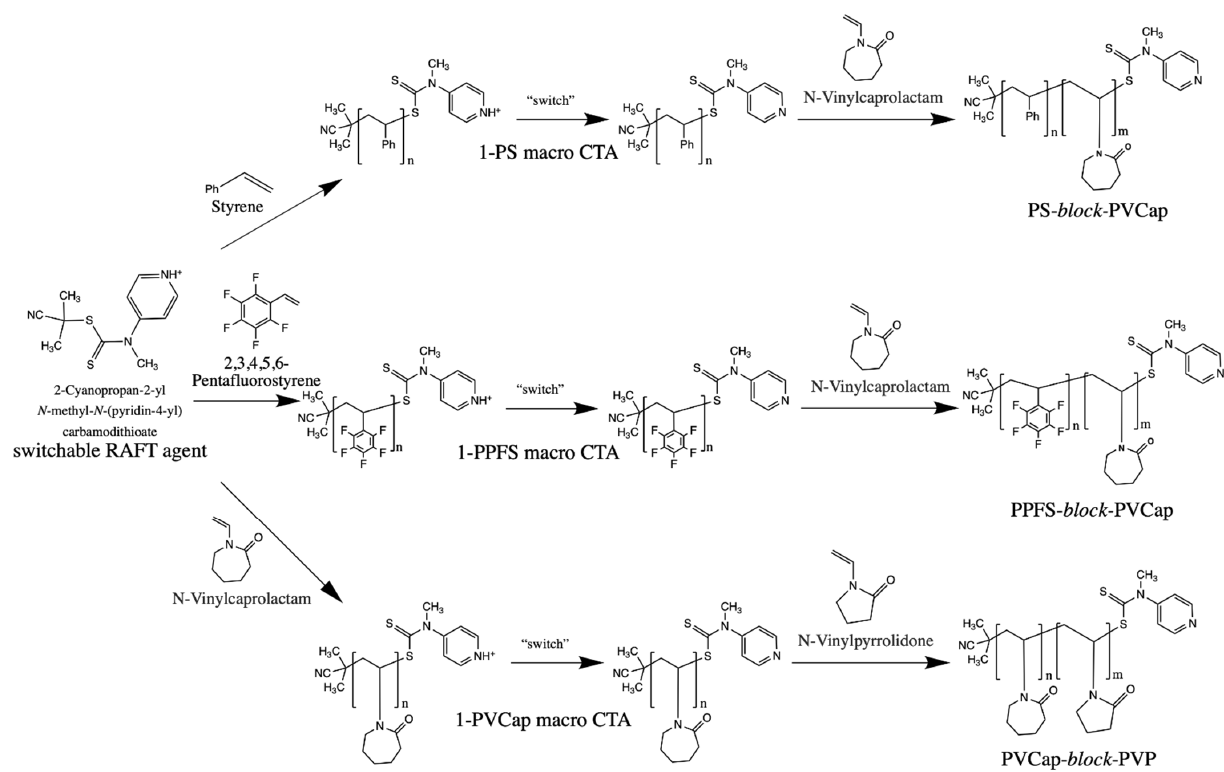
Figure 2. Reaction scheme for synthesis of (less activated monomer (LAM))-block-(more activated monomer (MAM)) copolymers used as kinetic hydrate inhibitors (KHIs). Monomers of styrene, 2,3,4,5,6-pentafluorostyrene, or N-Vinylcaprolactam are first synthesized with a switchable RAFT agent to form a macro chain-transfer agent (CTA). The CTA is then extended with N-Vinylcaprolactam, or N-Vinylpyrrolidone after having been switched to its deprotonated form. Table 1. Experimental reaction conditions for polymerization of 1-poly(styrene) (1-PS), 1-poly(2,3,4,5,6-pentafluorostyrene) (1-PPFS), and 1-poly(vinyl caprolactam) (1-PVCap) macro chain-transfer agent.